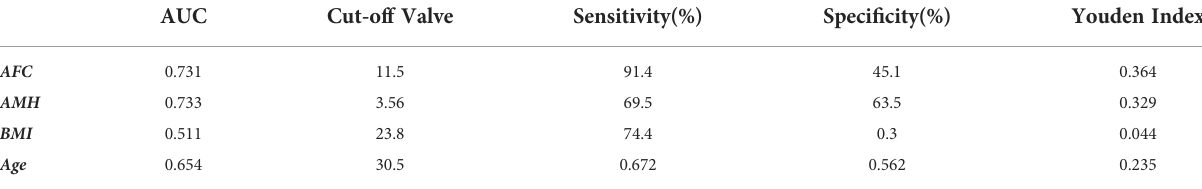
TABLE 5 Predictive comparison of different in fl uence factors and high ovarian response.